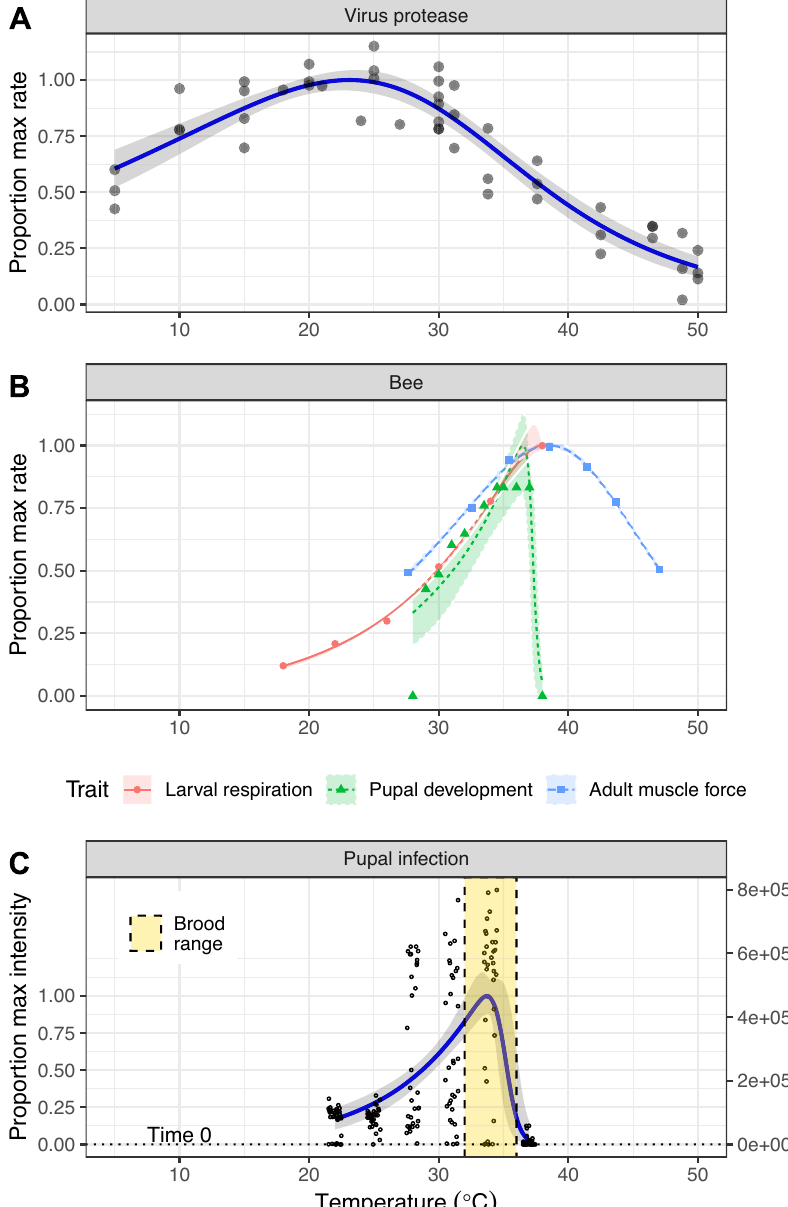
Fig. 1 Effects of temperature on Deformed wing virus, honey bees, and infection. Panels show data (points) and model predictions (lines), and 95% bootstrap con fi dence intervals (shaded bands) for virus protease activity ( A , upper panel), three bee traits ( B , middle panel), and pupal infection ( C , lower panel). Data for larval respiration (red circles and solid line), pupal development (green triangles and dotted line), adult muscle force production (blue squares and dashed line), and brood temperature range (yellow vertical region in infection panel) taken from previous observations 20,24,26,45 . In the lower panel, the secondary y-axis indicates the raw sample luminescence (i.e., before transformation to proportion of maximum intensity) and the horizontal line dotted line represents the mean luminescence of n = 16 samples frozen immediately post-injection. To provide a comparable scale for the different measurements, raw values for all traits are shown as proportions of the trait ’ s peak model-predicted